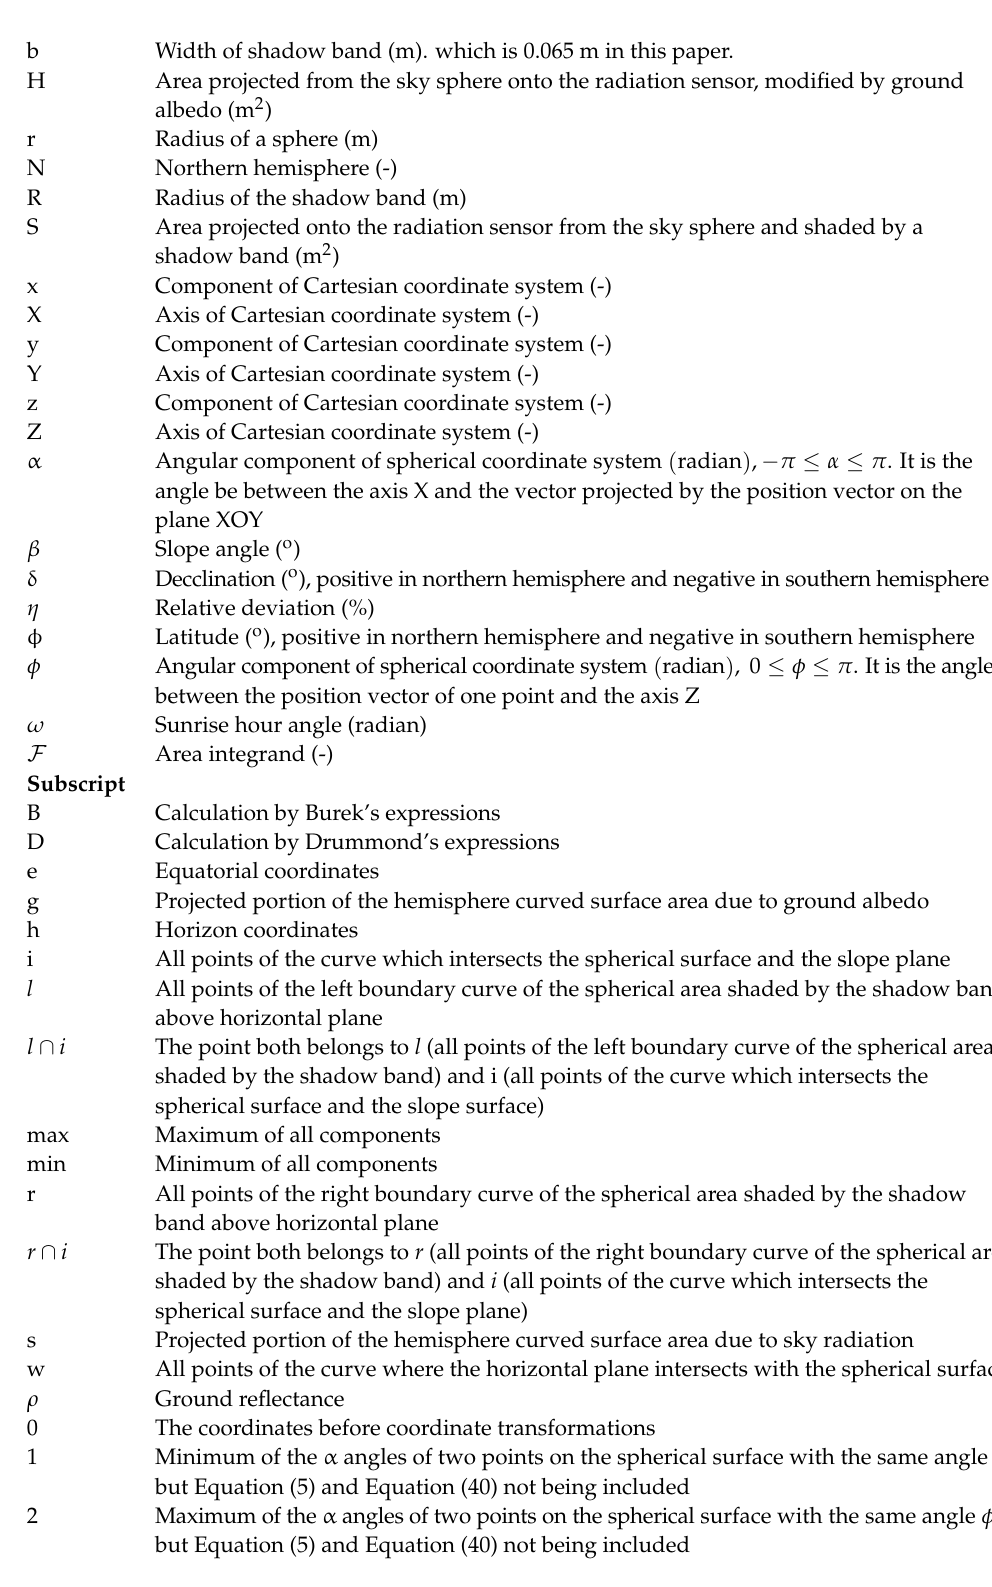
Maximum of the α angles of two points on the spherical surface with the same angle φ , but Equation (5) and Equation (40) not being